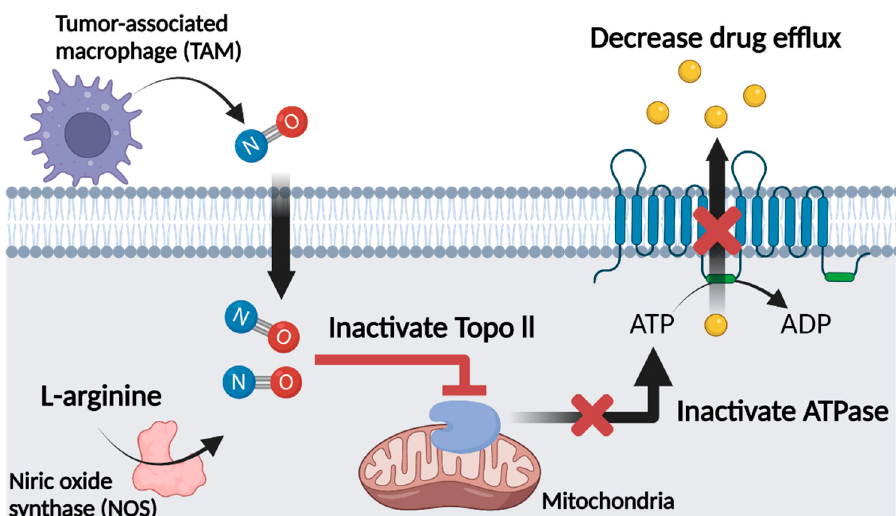
Figure 3. Mechanisms of NO-mediated MDR inhibition. Image created with BioRender icons. NO is produced by TAM or the cancer cell itself, and internalized NO mediates enzyme activities in cells. In mitochondria, NO inactivates topo II enzyme activity by S-nitrosylation. Since topo II is responsible for ATPase activity of ABC transporter, NO-induced topo II inactivation leads to inhibition of ABC transporter. Thus, ABC transporter-mediated drug efflux is decreased, resulting in drug accumulation in the cell.